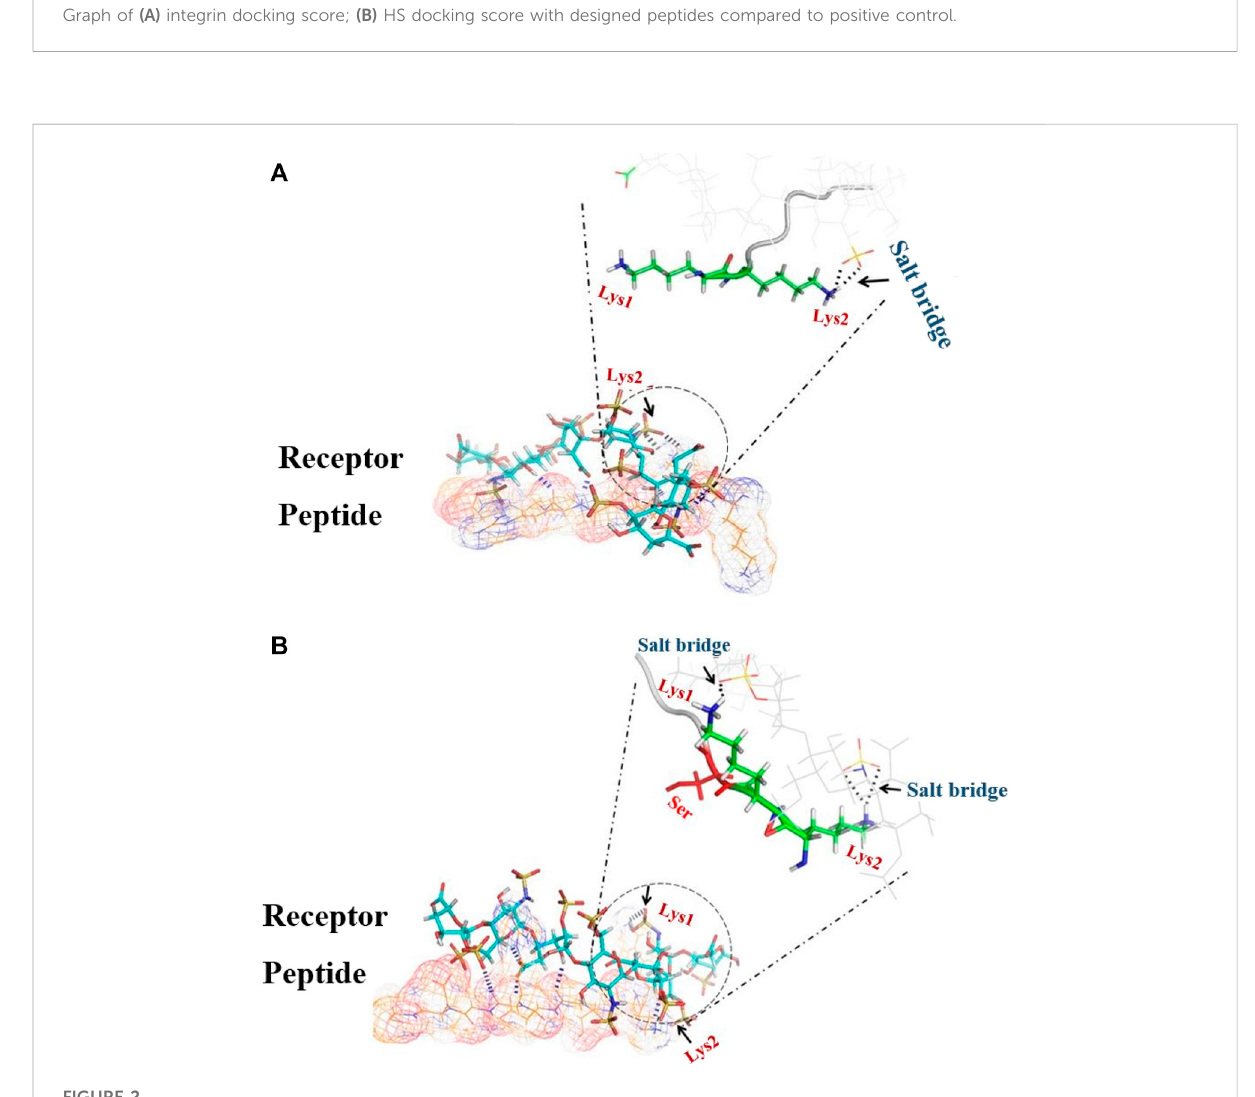
FIGURE 2 3D image of the dP-HS complex; the main interaction energy comes from hydrogen bonds (blue dashes) and salt bridges (black dashes). (A) In dIBP-HS, only Lys2 forms a salt bridge (black arrow) with HS. (B) In dHBP-HS, both Lys1 and Lys2 form a salt bridge with HS.